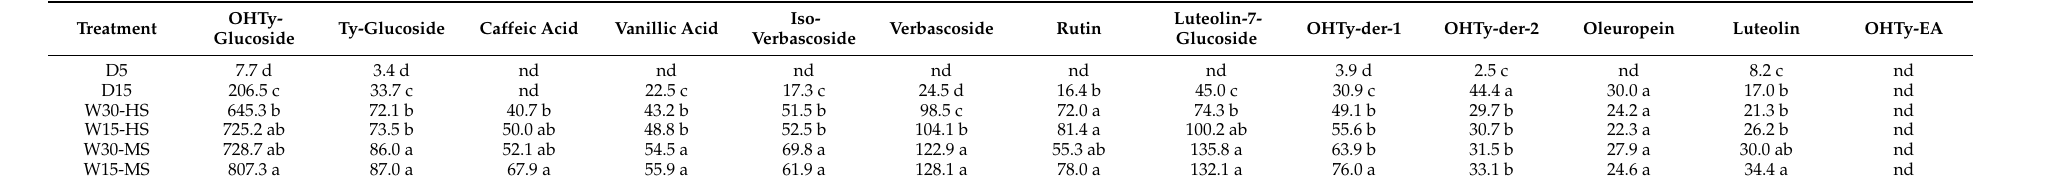
Table 2. Phenolic compounds analyzed by HPLC-DAD in the brine used to process ‘Itrana’ table olives after 5 and 15 days of fermentation in water (D5 and D15, respectively) and at the end of four 165-day-long processing methods: 30 days in water and then salting with 8% NaCl brine (W30-HS); 15 days in water and then salting with 8% NaCl brine (W15-HS); 30 days in water and then salting with 6% NaCl brine (W30-MS); 15 days in water and then salting with 6% NaCl brine (W15-MS). Within each column, different letters indicate significant differences between treatments according to Tukey’s test ( p ≤ 0.05). Values are expressed as mg internal standard per L of brine ( n =